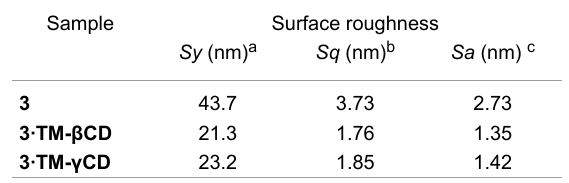
Table 4: Roughness and grains parameters collected from 3 × 3 µm 2 AFM images of 3 , 3·TM- β CD and 3·TM- γ CD thin films.